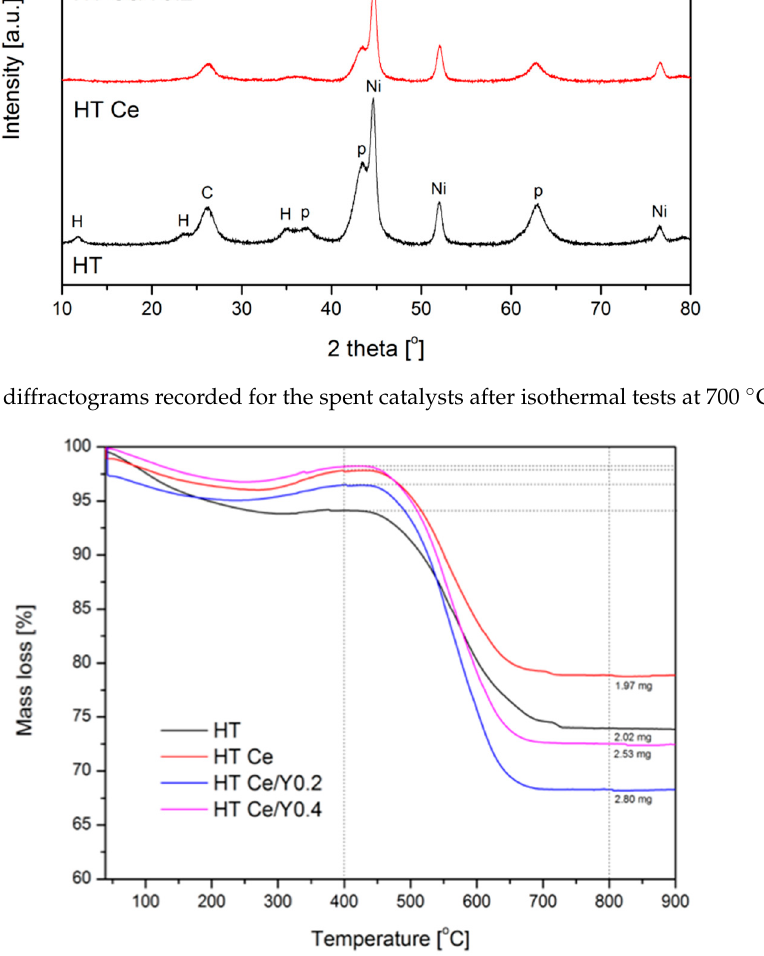
Figure 9. Mass spectrometry (MS) signals of water vapor and carbon dioxide during thermal decomposition of the spent catalysts. Raman spectra after isothermal tests are presented in Figure 10. For all samples four characteristic peaks located at 1473 cm − 1 (D band), 1573 cm − 1 (G band), 1602 cm − 1 (D’ band), and 2644 cm − 1 (G’ band) can be observed. The D-band is related to the disordered structural form of crystalline carbon species, whereas G-band is associated with graphitic carbon having high order, symmetry, and crystallinity. The degree of the carbon crystallinity (I D /I G ) is shown in Table 3. The highest contribution of the graphitized carbon was observed for HT Ce catalyst, giving the lowest I D /I G ratio, i.e., 1.47. For the HT Ce/Y0.2 catalyst less graphitic carbon was observed than for HT Ce, despite the higher mass loss in the TGA analysis (cp. Figure 8). Thus, although the low loadings of yttrium (0.2 wt.%) led to the creation of higher amount of carbon, such deposits had lower graphitization degree.